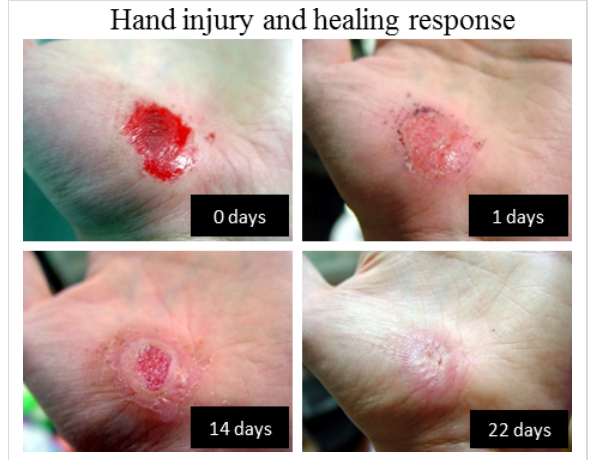
Figure 1: Photographs of a hand injury healing over time. The pictures show the immediate need for a healing response to stop blood loss all the way through remodeling and scarring after 22 days. Adapted from